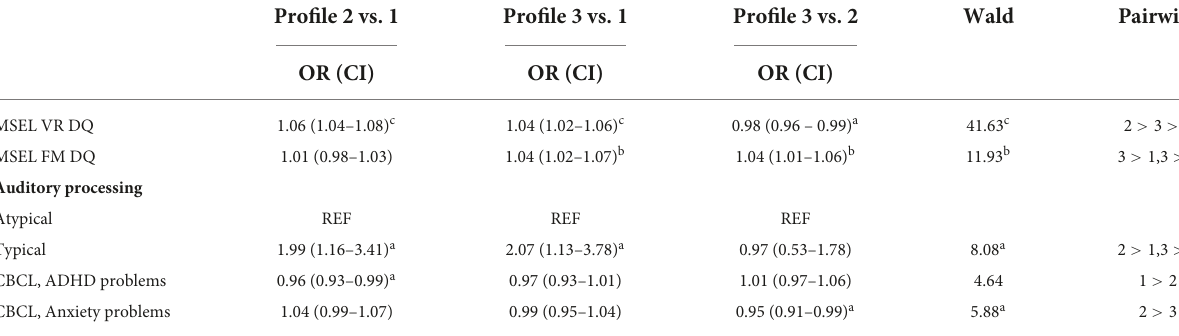
TABLE 5 Parameter estimates of the child-based factors multinomial logistic regression